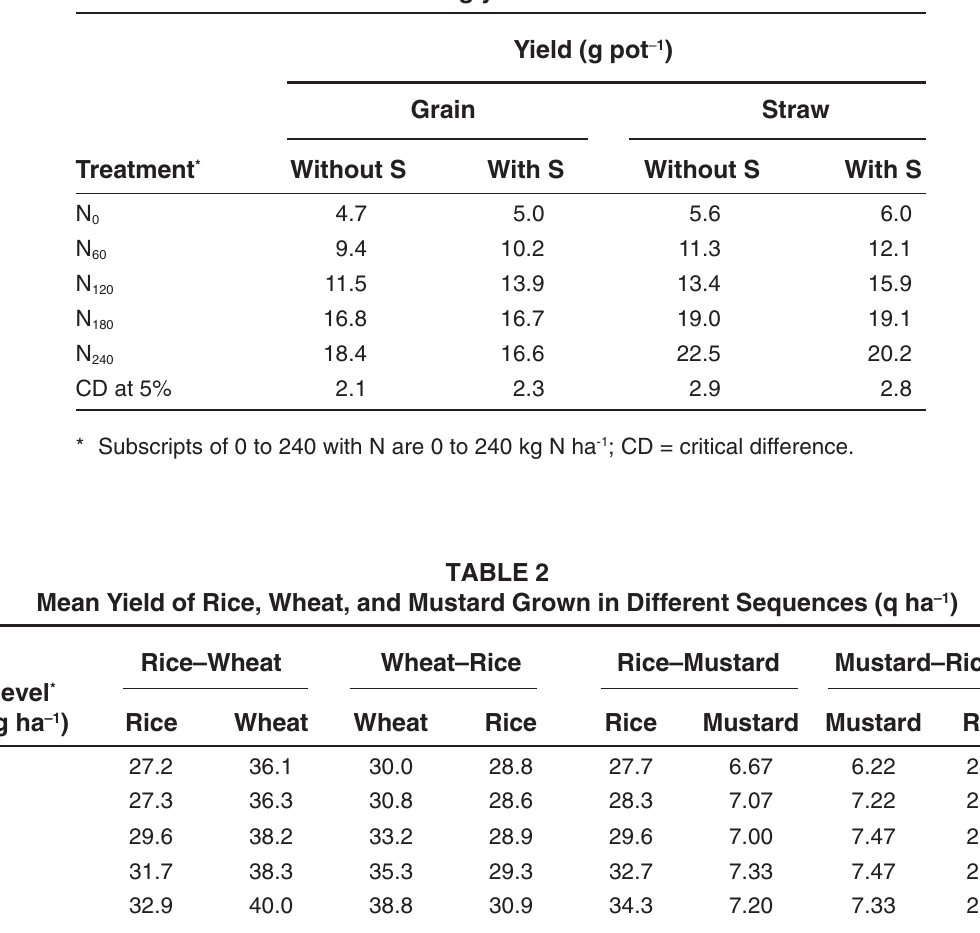
Grain and Straw Production by Wheat with the Application of N and S in Increasingly Wider Ratios